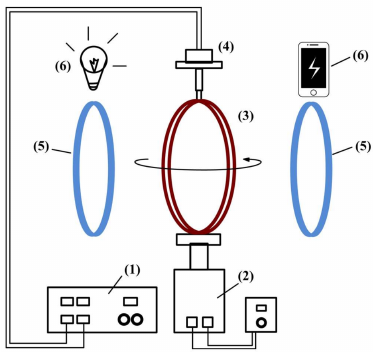
Figure 5. A structure schematic of the omnidirectional wireless power transfer (WPT) system based on rotary transmitting coil for household appliances: (1) WPT power supply; (2) electric rotating motor; (3) rotary transmitting coil; (4) electric slip ring; (5) receiving coils; and (6) household appliances (i.e., electric lamps or mobile